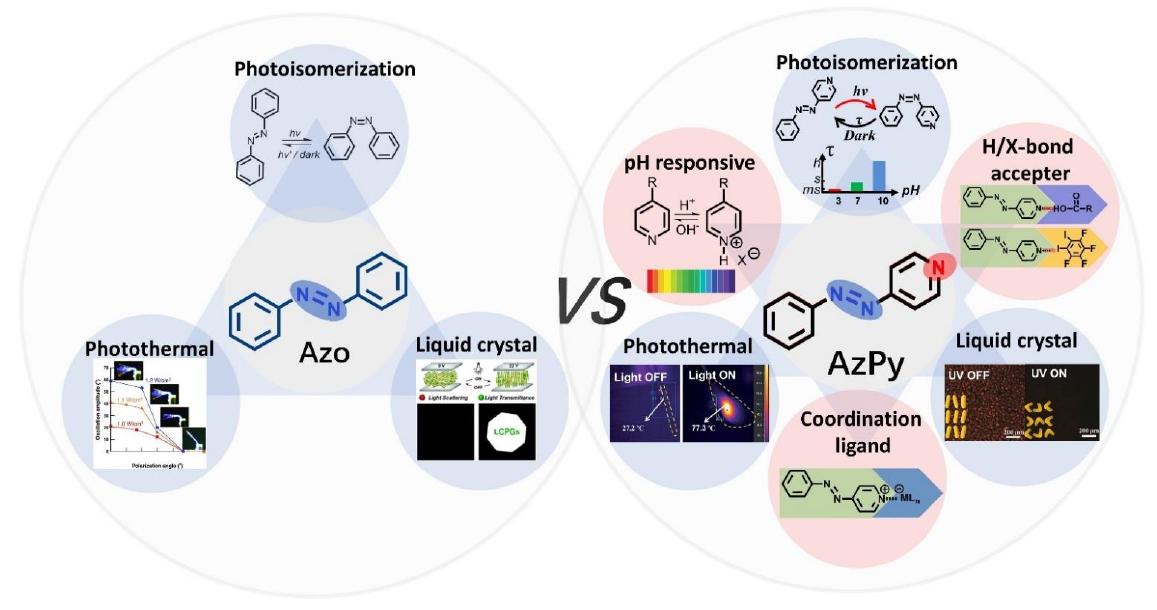
Figure 1. Scheme of multiresponsive properties of azobenzene and azopyridine (AzPy) and their applications from photonics to nanotechnology.